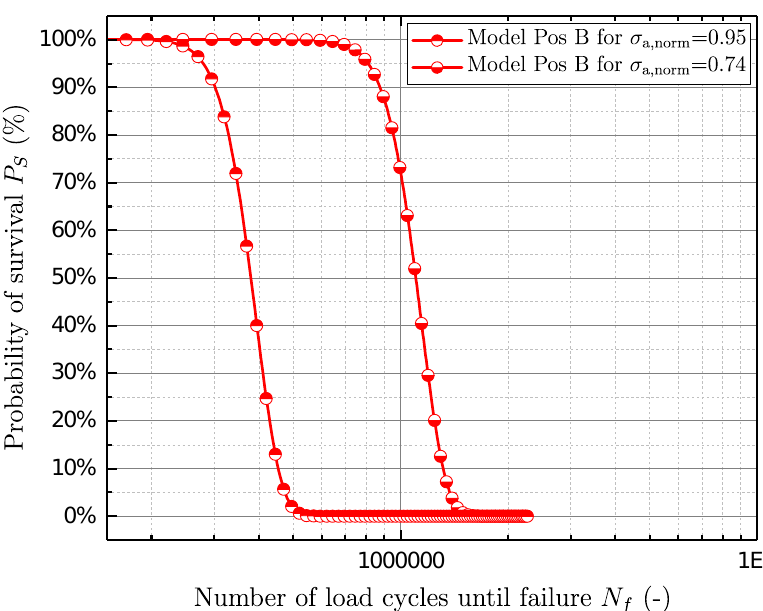
Figure 22. Validation of the model in the finite-life region position